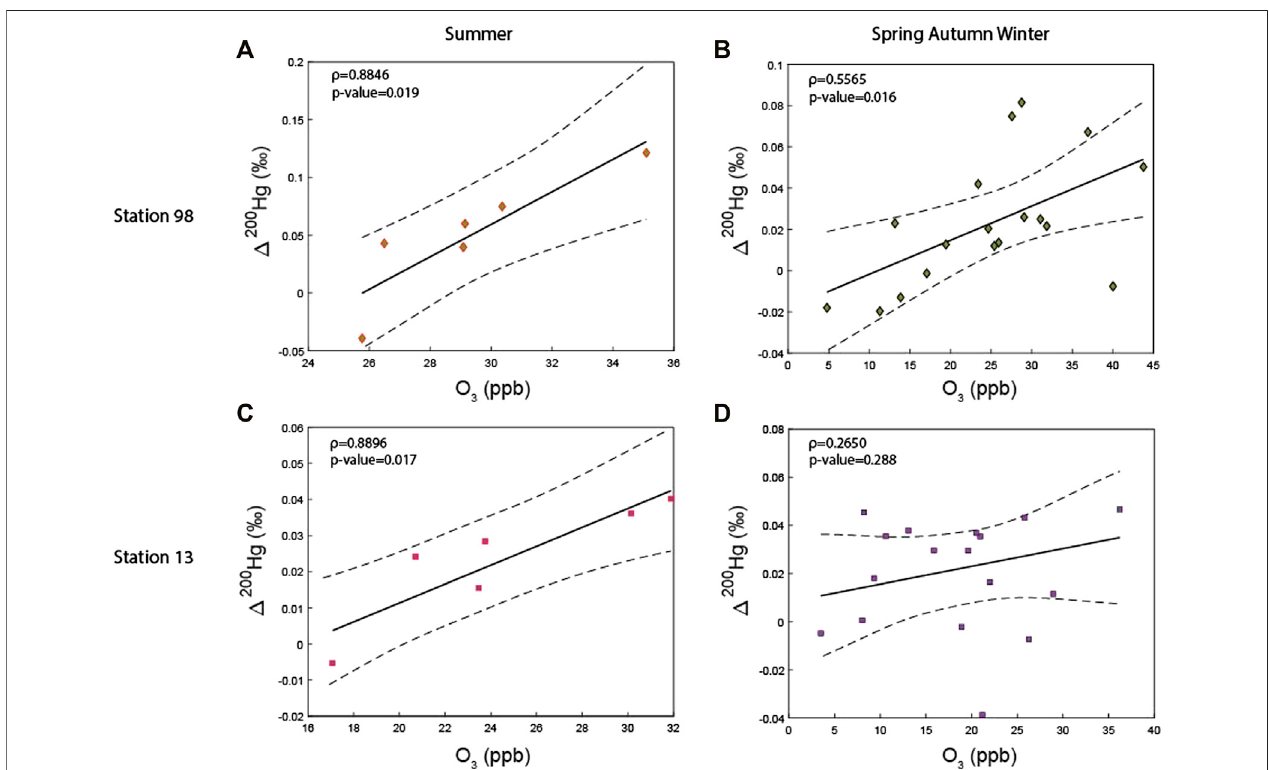
FIGURE5| Positivelinearrelationshipsobservedbetween Δ 200 Hgandozoneconcentrationsatstation98during (A) summer, (B) springautumnandwinter,andat station 13 during (C) summer and (D) spring autumn and winter. The correlation signi fi cance is calculated using a Spearman correlation.